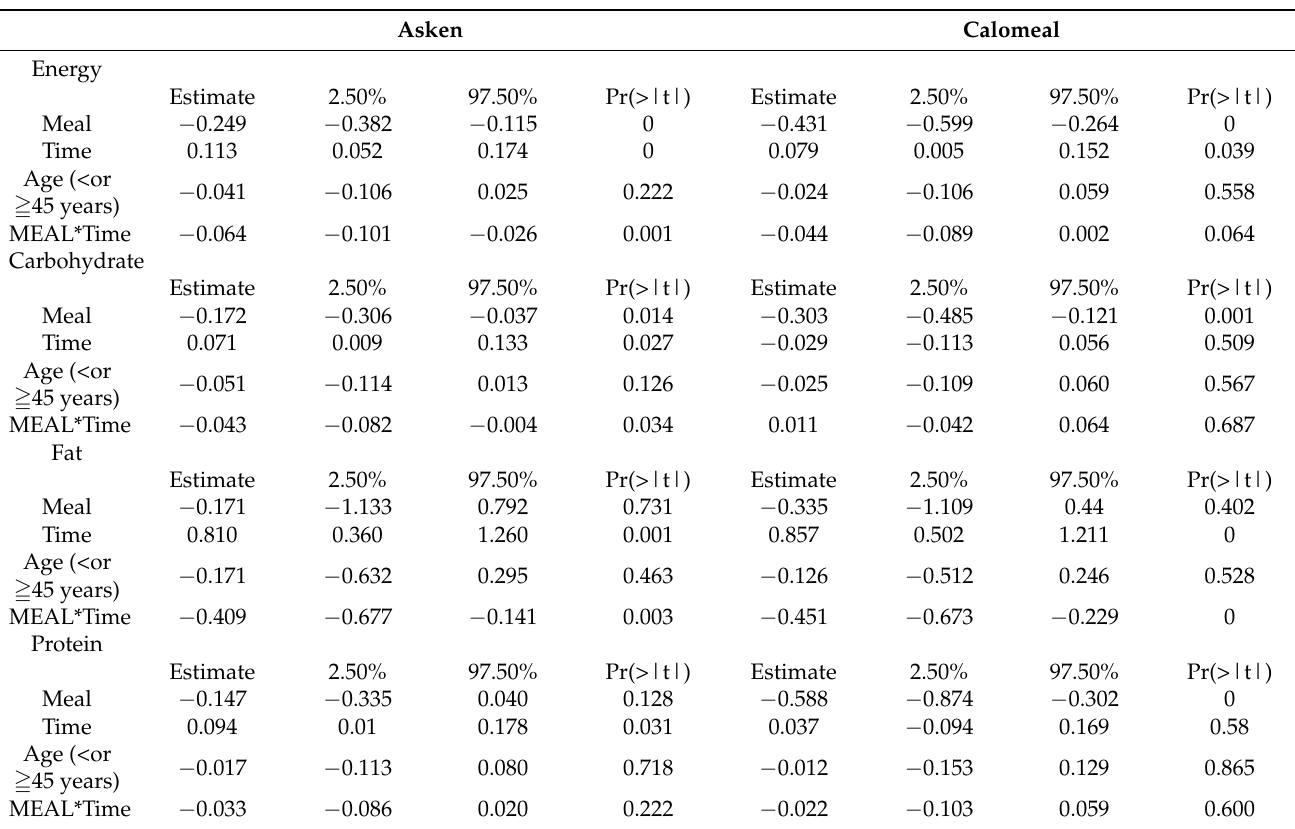
Table 1. Linear-mixed-model results.